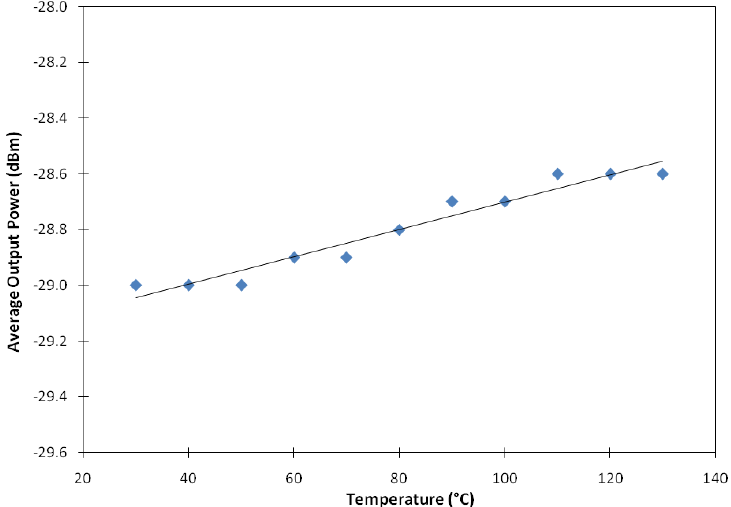
Figure 8. The average output power of the ASE against